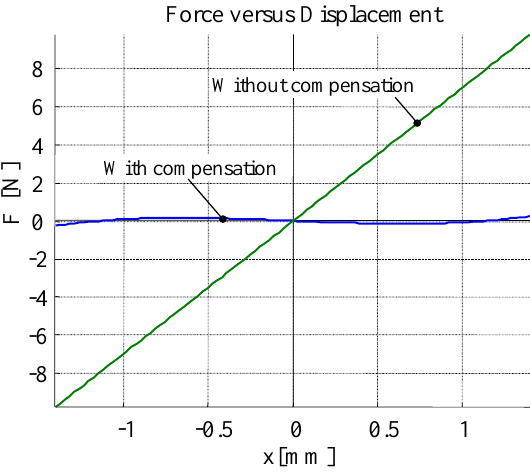
Figure 2. Force applied on the mobile block (c) (Fig. 1, right) as a function of its displacement with and without sti ff ness compensa-